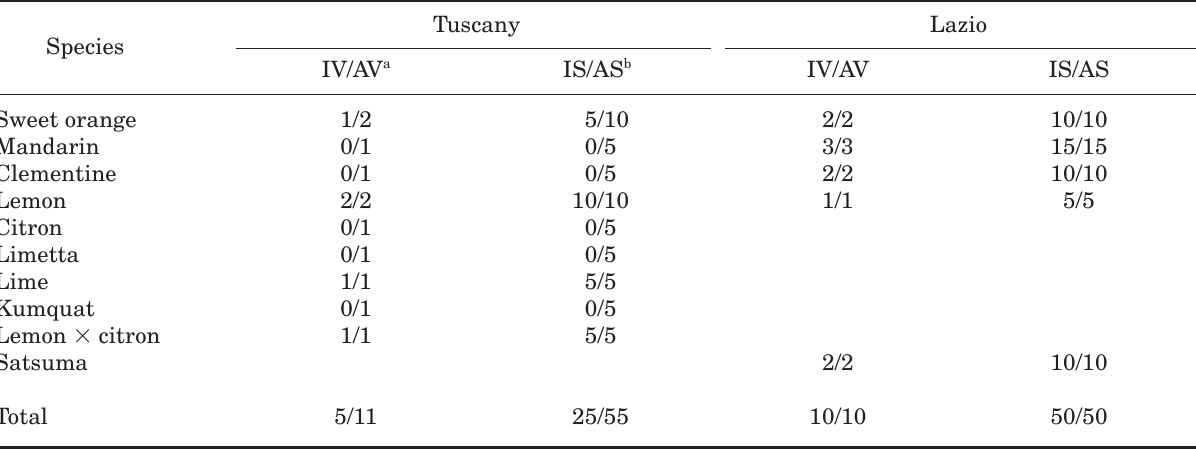
Table 1. List of analyzed citrus species and varieties and of infections recorded. Species Variety CEVd HSVd Not infected Sweet orange Sanguinello + Navelina + Tarocco + Tarocco nucellare + Mandarin Beatrix + San Francesco + + Tardivo di Ciaculli Primo Sole Satsuma Miho + Miyagawa + Clementine Clementina + Hernandina Rufina Lemon Femminello carrubaro + Femminello comune + Variegato + Citron Etrog + Limetta Pursha + Lime Pinocchio + Kumquat Fortunella +